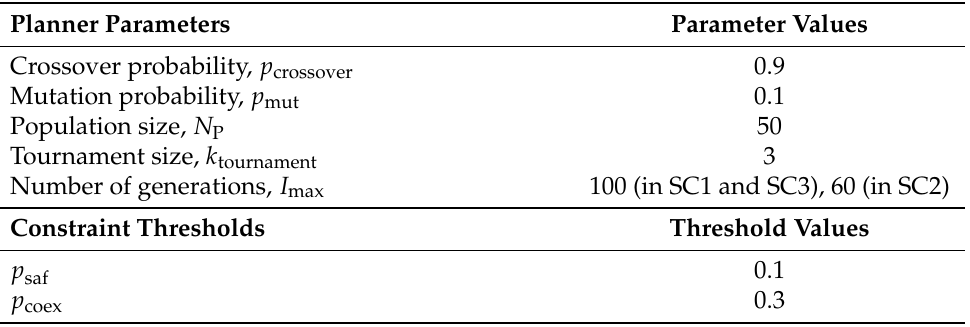
Table 3. Planner configuration